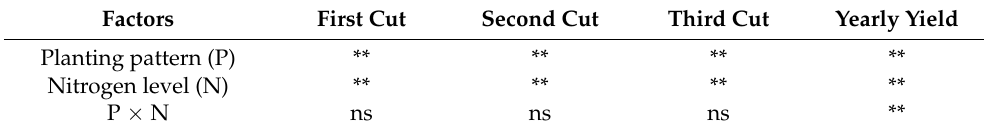
Table 3. Variance analysis of planting pattern and nitrogen level impact on alfalfa yield.